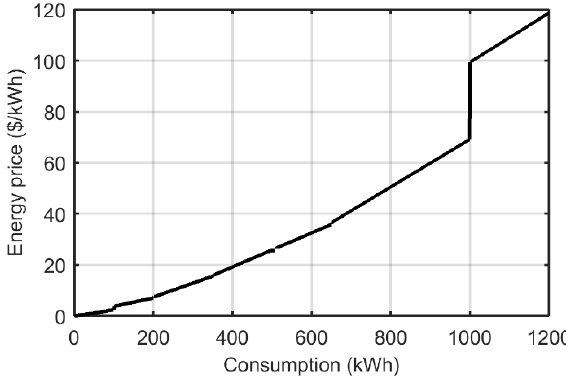
Figure 7. Energy consumption bill in Egypt.